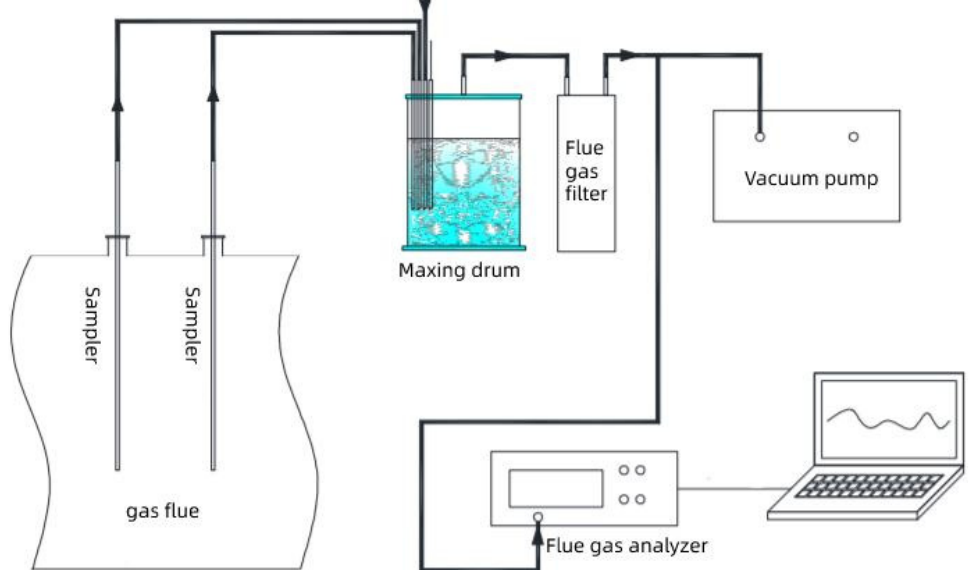
Figure 5. Layout of flue gas composition measuring equipment.